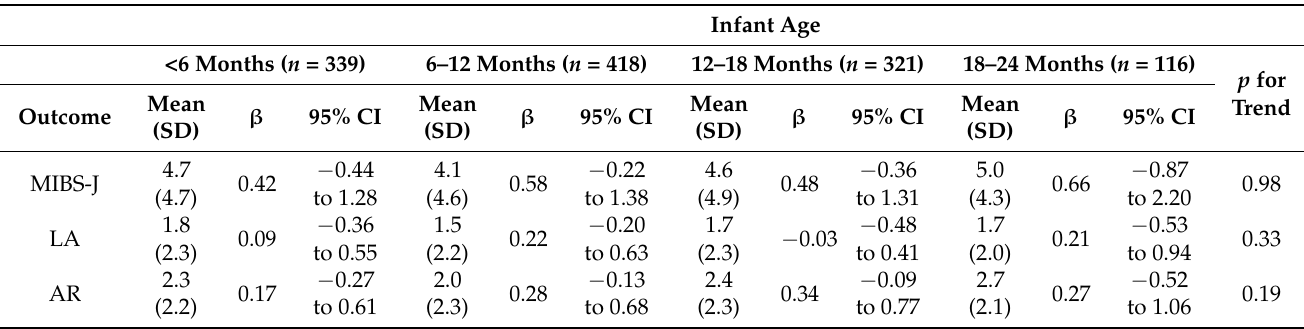
Table 4. Stratified analysis of the association between paternity leave taking and father–infant bonding by infant